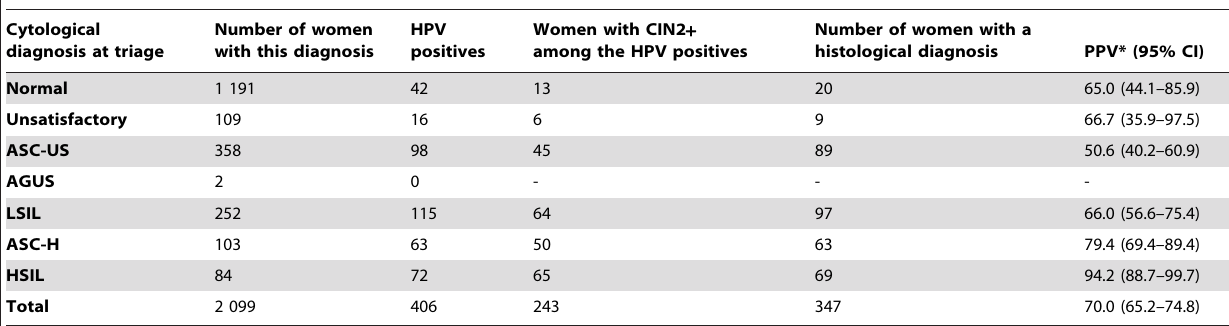
Table 1. Triage of women with ASC-US or LSIL.